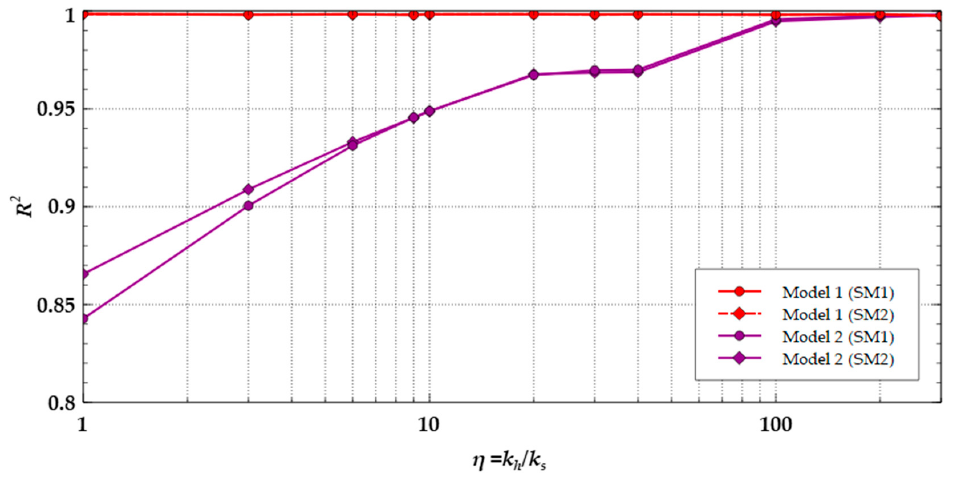
Figure 6. Model performance with R 2 .